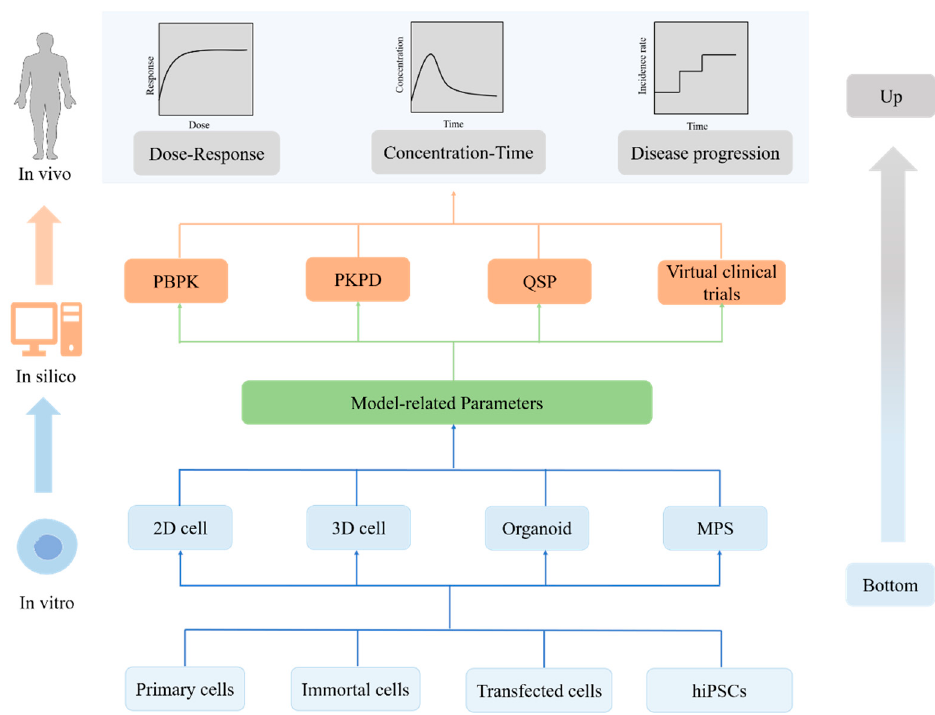
Figure 3. The progress of in vitro to in vivo translation. It is a bottom-up research method. Through high-quality in vitro experimental data and mathematical models, more accurate predictions of in vivo outcome can be obtained. PBPK: physiologically based pharmacokinetic model; PK/PD: pharmacokinetic/pharmacodynamic model; QSP: quantitative systems pharmacology model; MPS: microphysiological system; hiPSC: human-induced pluripotent stem cell.